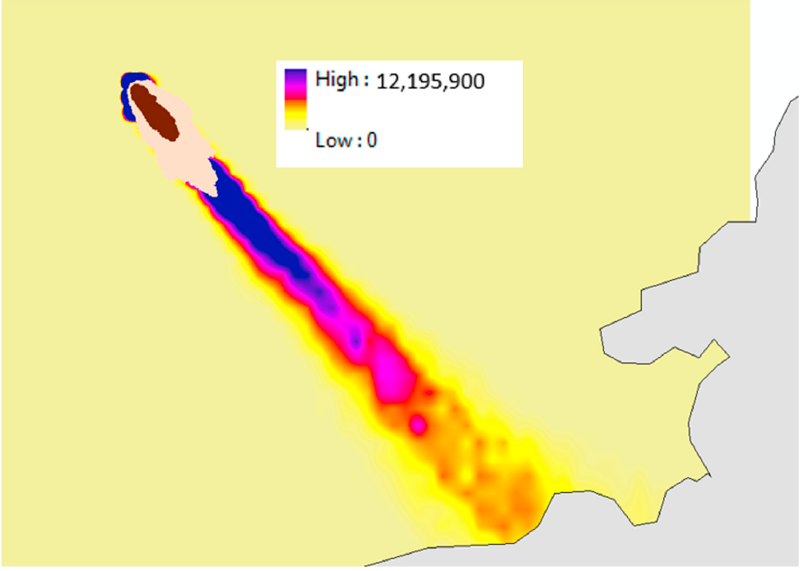
Figure 9. Fire total simulation—2 hours (out of total 4) and smoke total simulation ( μ gr/m 3 )—8 hours.